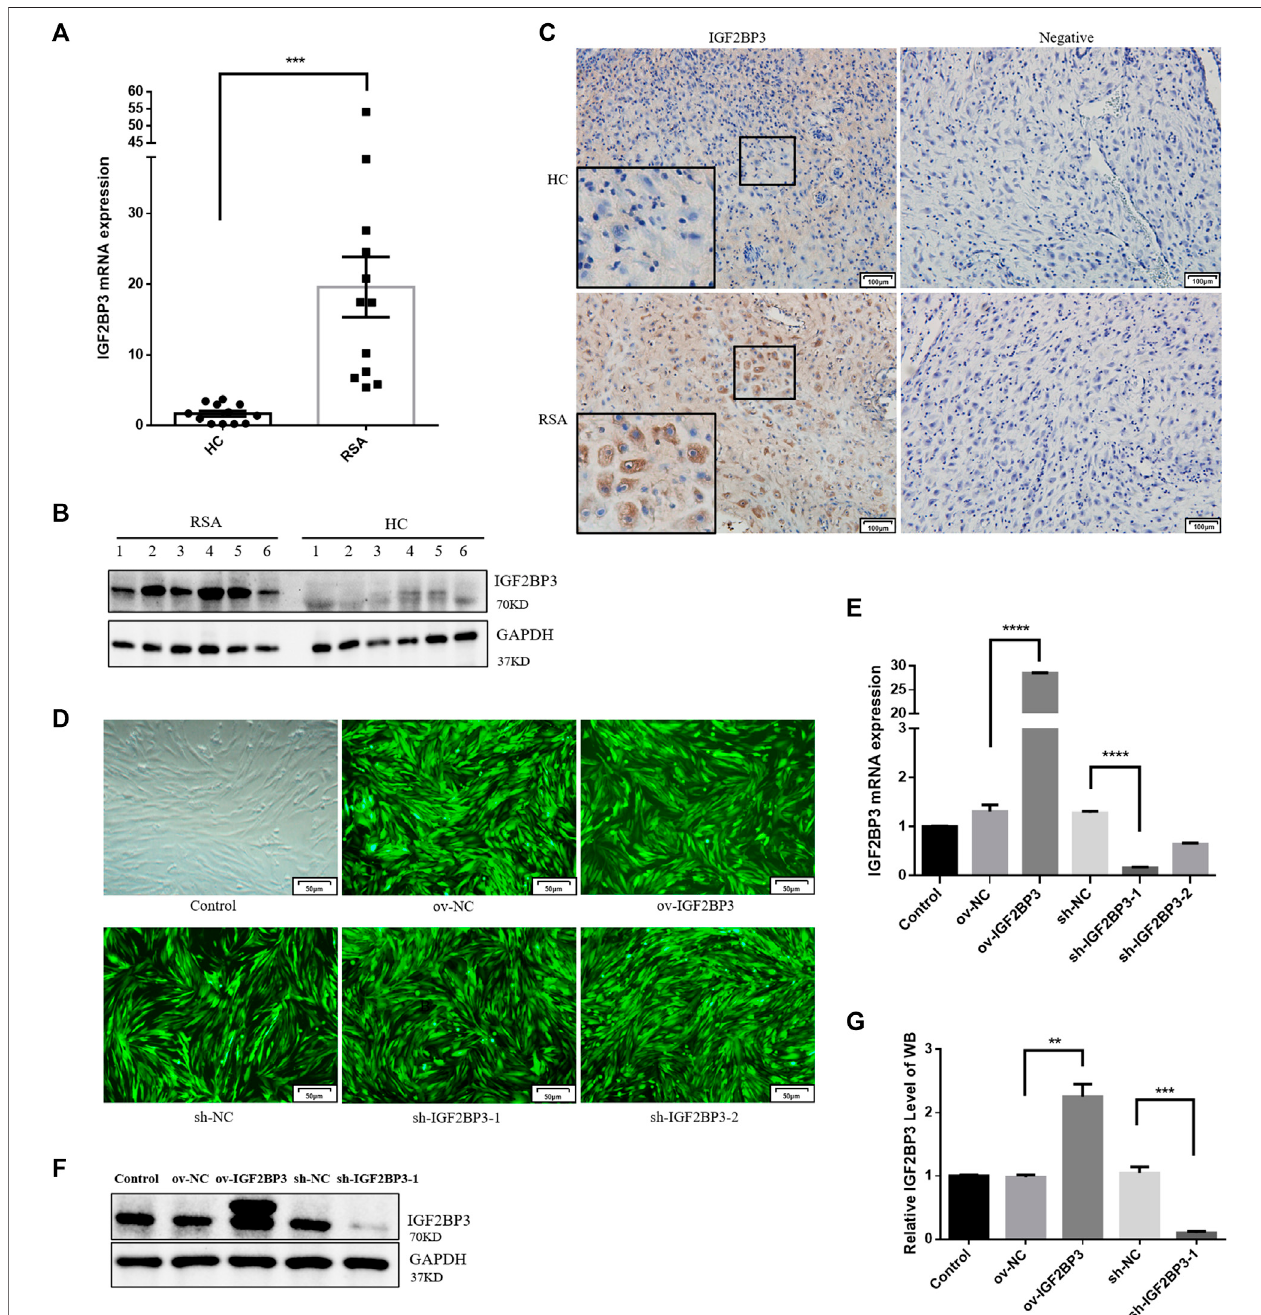
FIGURE 1 | IGF2BP3 in decidual tissues and constructing cell models (A) IGF2BP3 mRNA levels in the decidual tissues of RSA patients and HCs ( n = 12 for each group) were measured by qPCR. The relative RNA amount was calculated using the 2 − ΔΔ Ct method and normalized to internal control GAPDH, (B) IGF2BP3 protein levelsrelativetoGAPDHweredeterminedbyWesternblot( n =6foreachgroup), (C) immunohistochemicalstainingshowedthelocalizationandrelativequanti fi cationof IGF2BP3inrecurrentspontaneousabortion(RSA)andnormalpregnancy(HC)decidualtissues.Brownstainingrepresentsthetargetprotein.Insertsshowahigher magni fi cation of the square area. Scale bar = 100 μ m, (D) fl uorescence expression of hESC cells infected with lentivirus. Scale bars = 50 μ m, (E) qRT-PCR assays of relative IGF2BP3 mRNA expression showing its overexpression and knockdown in hESC cells, and (F,G) Western blot assays of relative levels of IGF2BP3 protein showing its overexpression and knockdown in hESC cells. Each experiment was independently performed three times. *** p < 0.001 and **** p < 0.0001 vs. control. HC, healthy control pregnancy; RSA, recurrent spontaneous abortion.